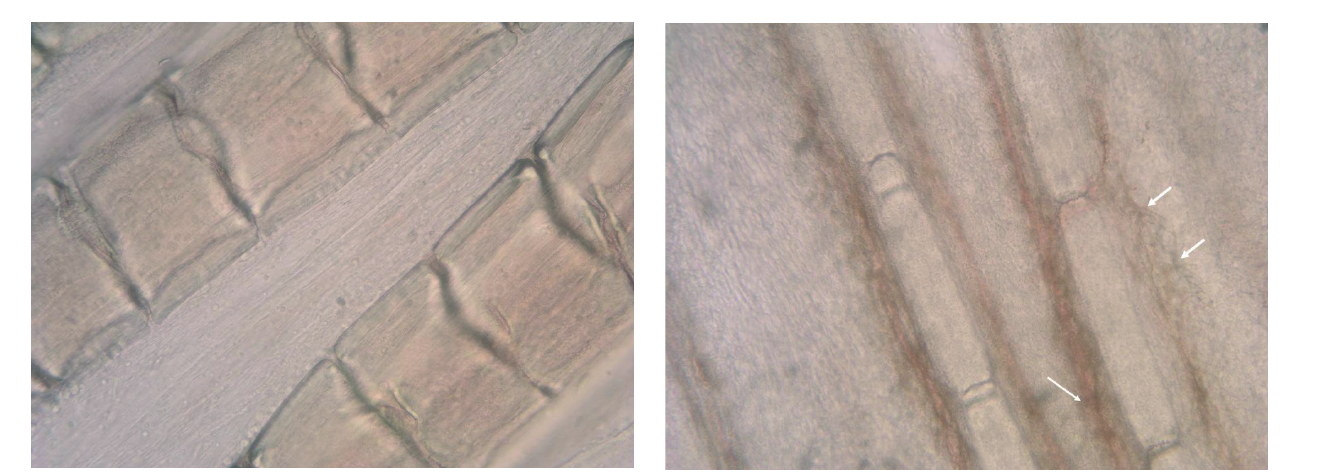
Fig. 1. Detail of the caudal-fin of a specimen of Stygichthys typhlops before the administration of L-DOPA (control); melanophores are not visible. Magnification 250 x.